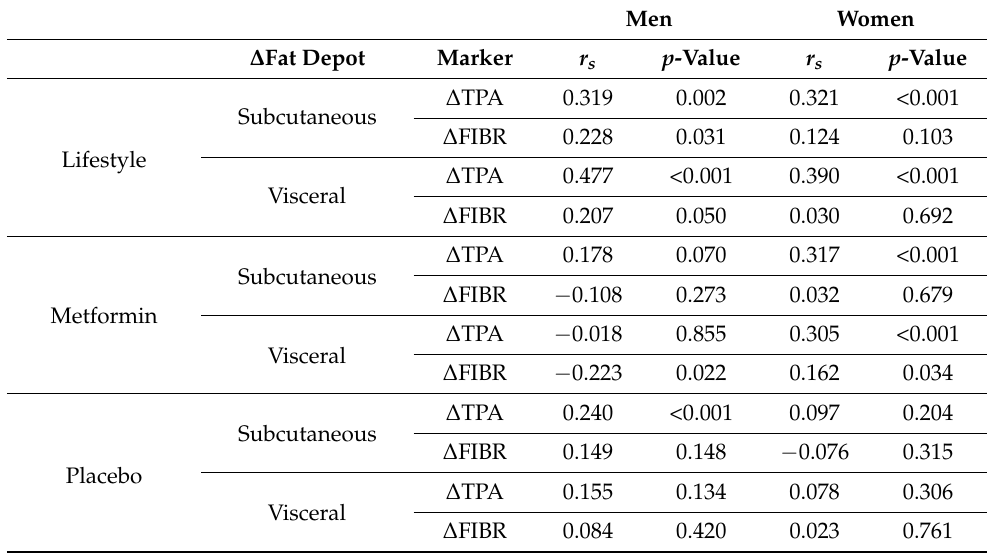
Table 4. Correlation between changes in size of different fat depots and changes in levels of TPA and FIBR in the DPP participants by